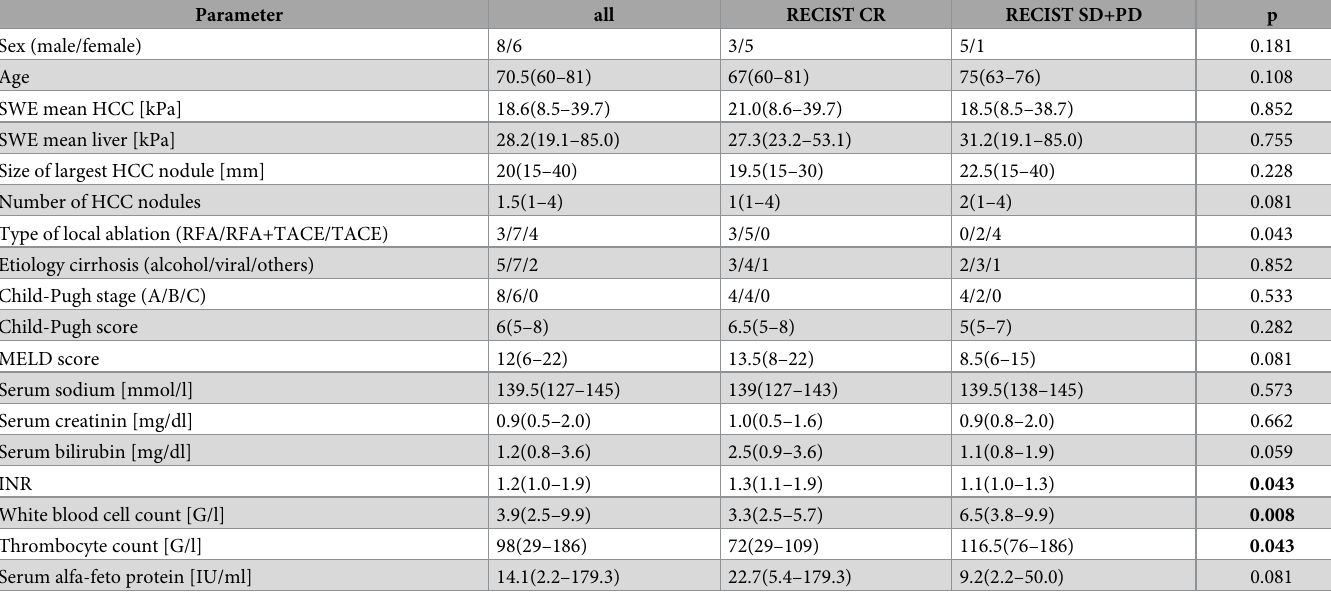
Table 3. Patient characteristics before local ablative therapy, stratified for RECIST